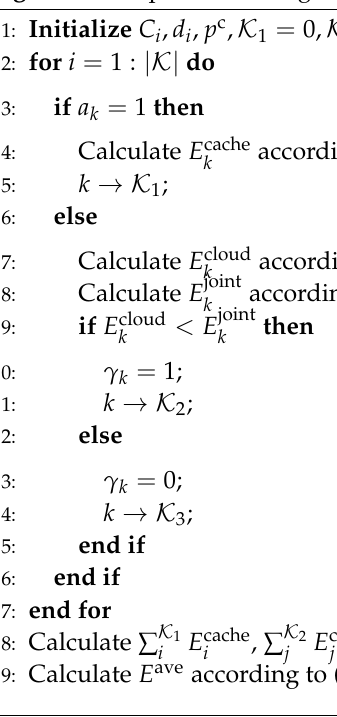
Algorithm 1 Optimal caching, cloud, and joint computing (CCJ)